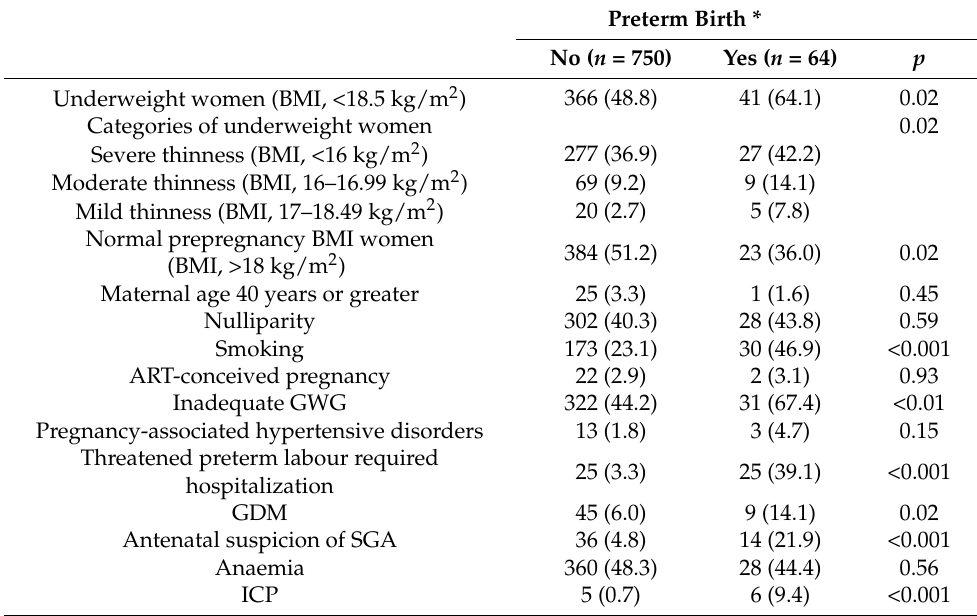
Table 2. Univariate analysis of preterm birth among underweight and normal prepregnancy BMI